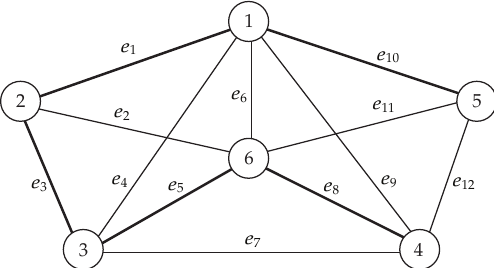
Figure 1: Given graph G .